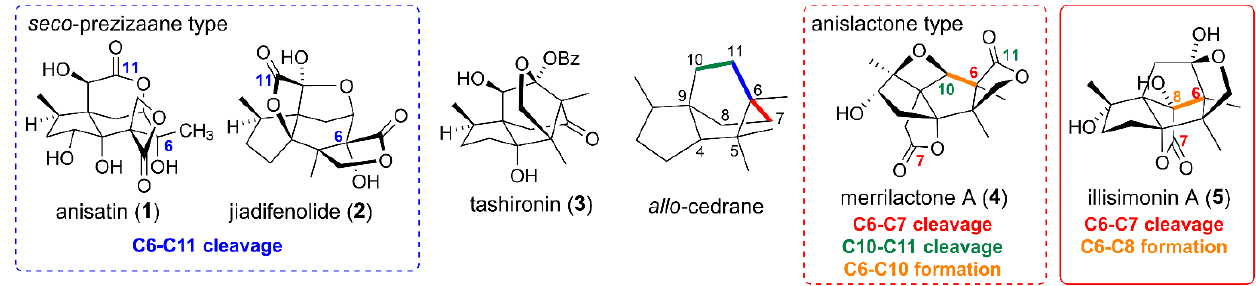
Figure 1. Illisimonin A and its related compounds.